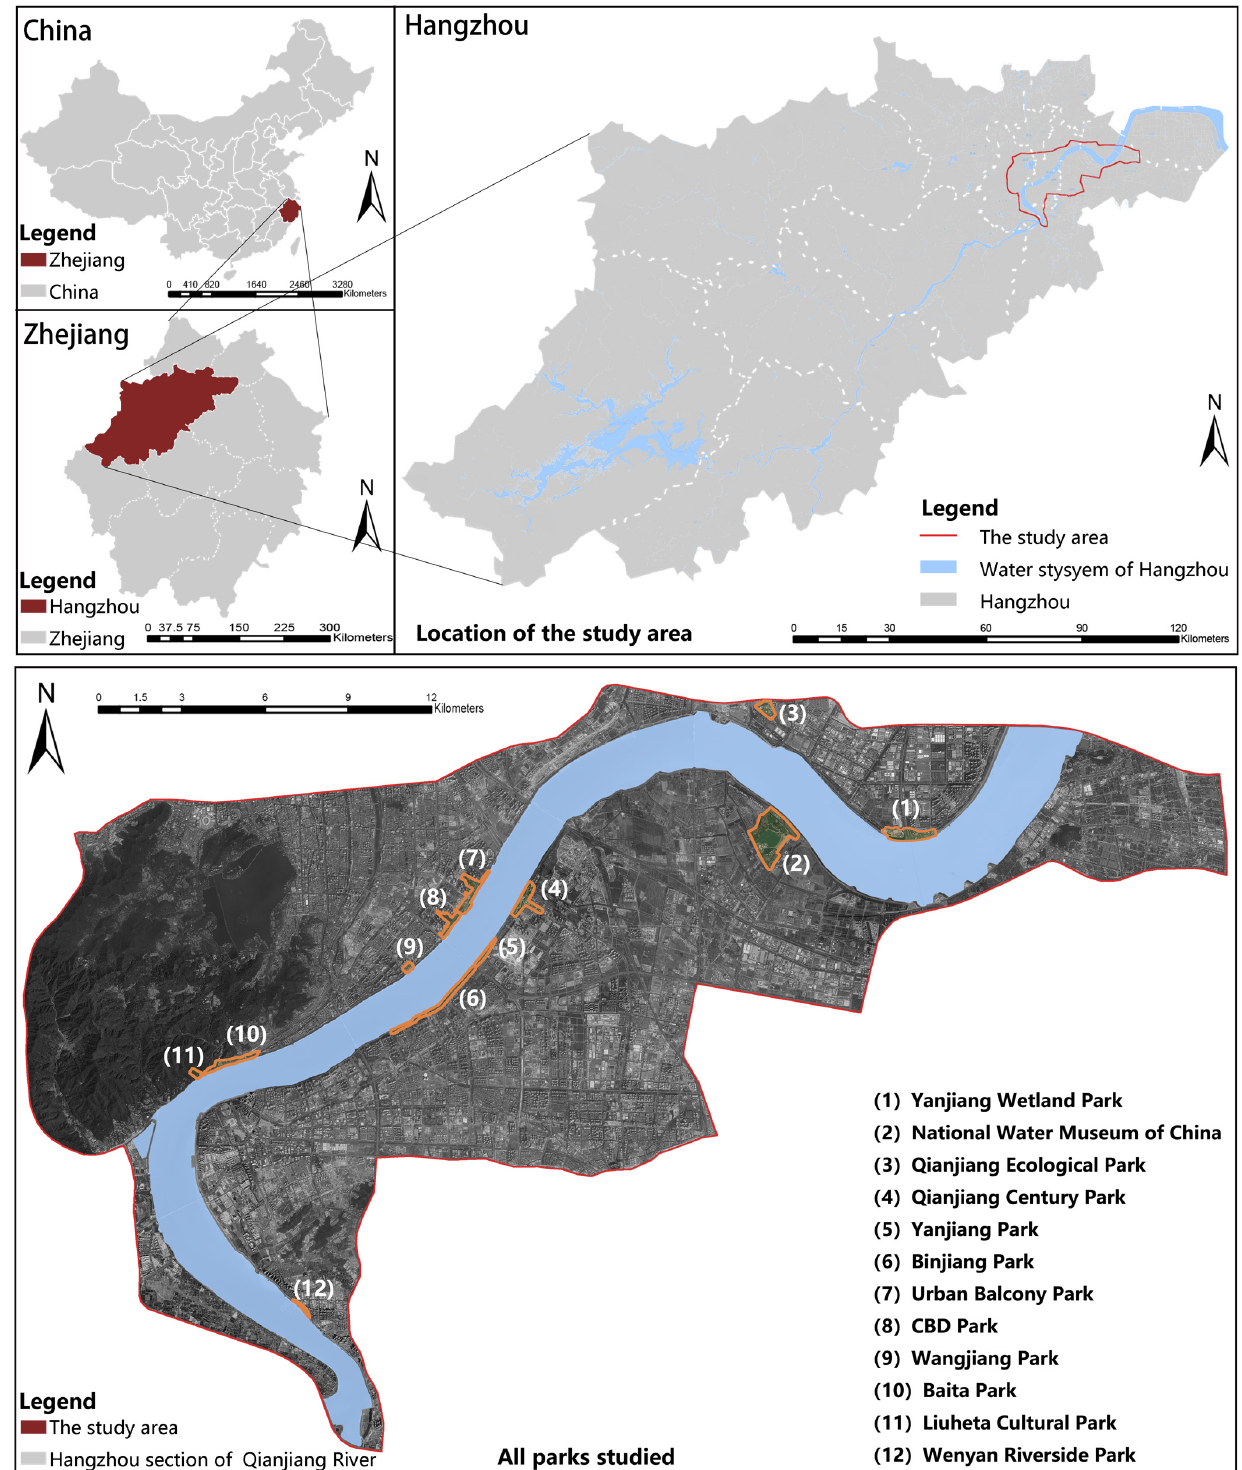
Figure 1. Location and distribution of waterfront parks.